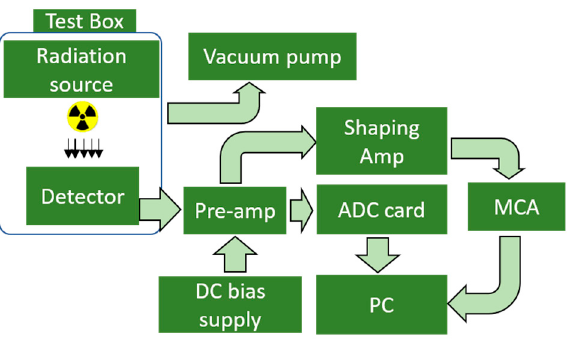
Figure 12. Schematics of a hybrid radiation spectrometer which can acquire analog PHS, as well as digital pulse shapes from a detector. The vacuum pump is used to evacuate the test box for alpha particle measurements.